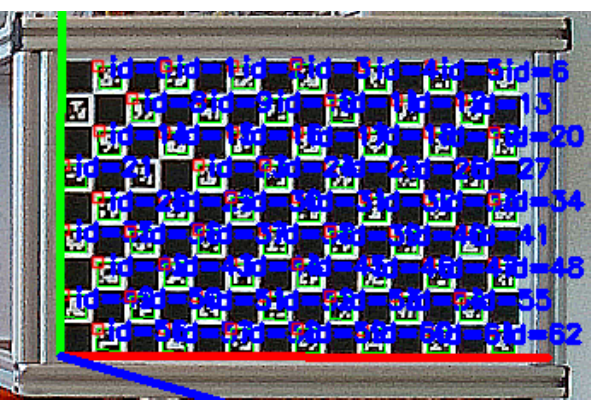
Figure 6. Charuco Board showing the identified ArUco